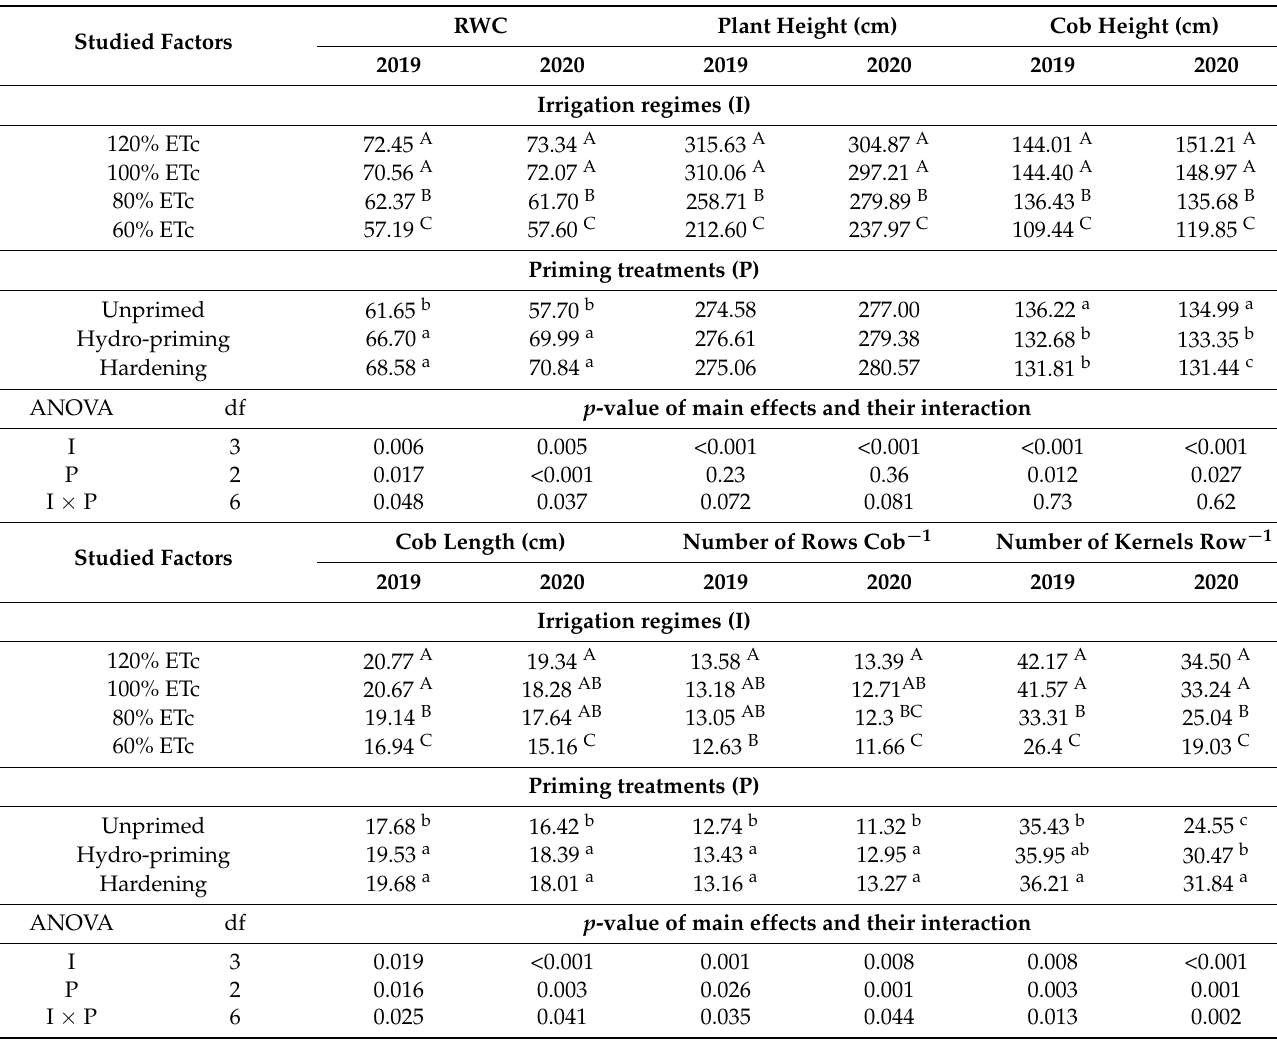
Table 4. Impact of irrigation regimes and seed priming treatments on relative water content (RWC), plant height, cob height, cob length, number of rows per cob and number of kernels per row during the growing seasons of 2019 and 2020. RWC Plant Height Studied Factors